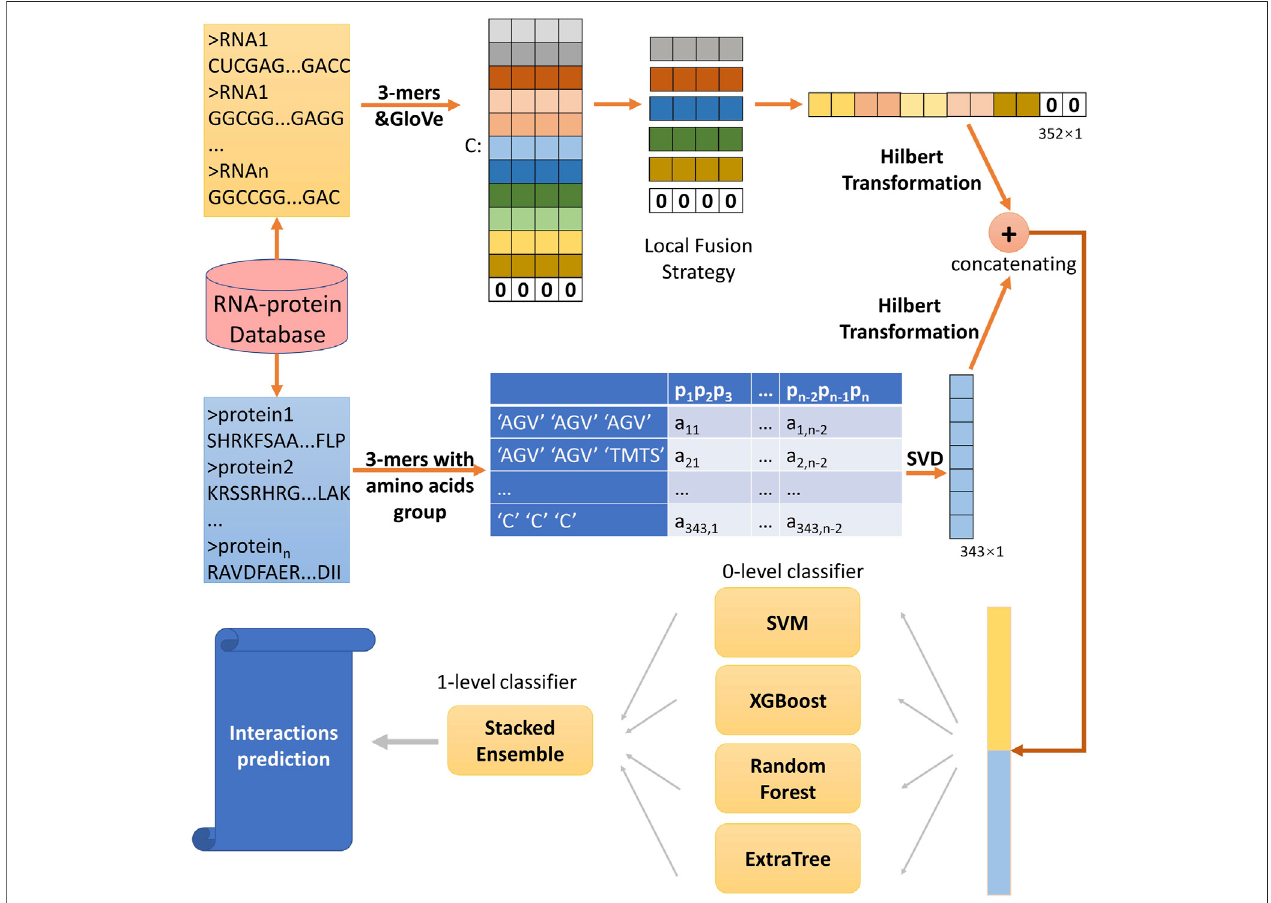
FIGURE 1 | Pipeline of the framework of SAWRPI.